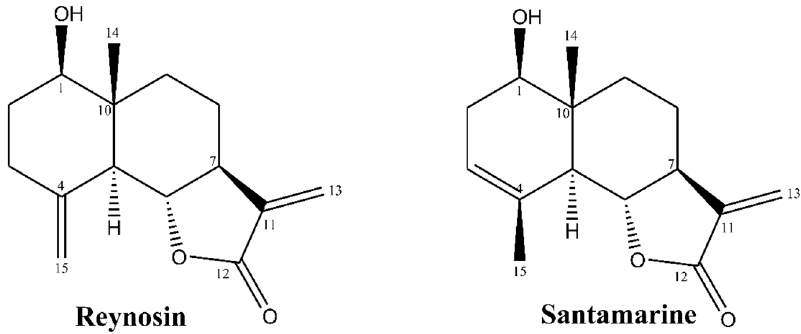
Figure 1. The chemical structures of reynosin and